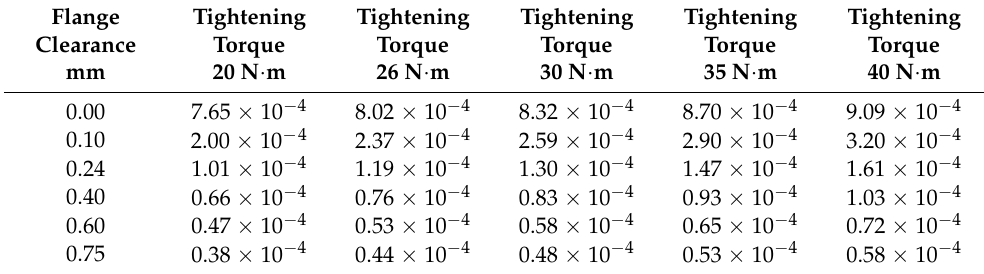
Table 2. Experimental contact area ratio for the assembled test section made of the Q345R–Q345R